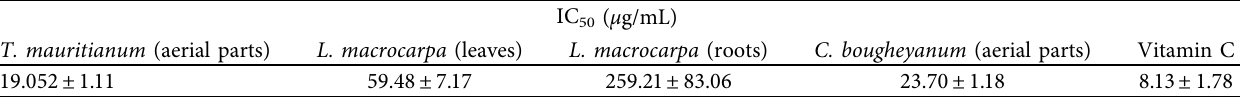
Figure 1: DPPH radical scavenging activity of plant extracts and vitamin C as a function of concentrations. Table 3: Antiradical efect (IC 50 in µ g/mL) of plant extracts scavenging DPPH-free